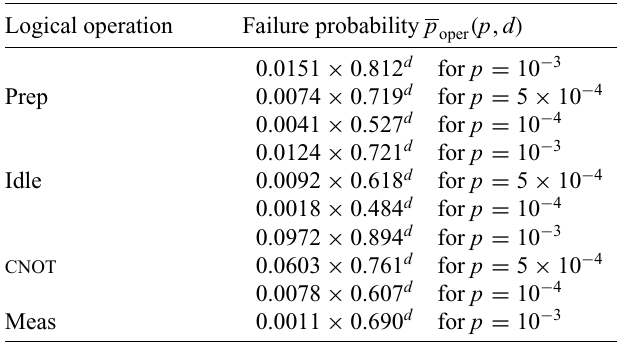
TABLE I. Failure probabilities of logical operations for the 2D color code as a function of the distance d . Since the failure prob- ability for logical Pauli measurements is negligible, we assume measurements to be perfect in the effective noise model, and report only the measurement failure probability for p = 10 − 3